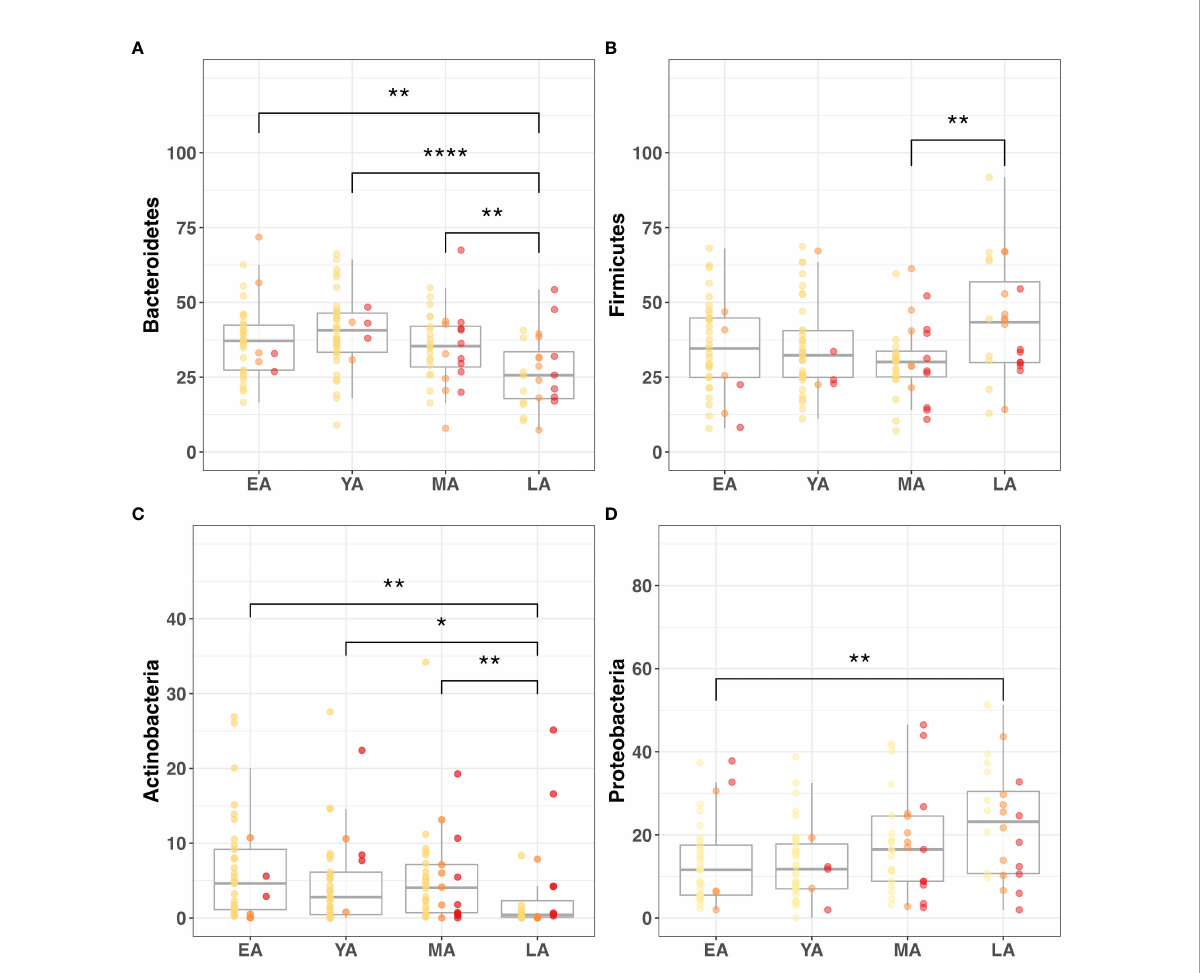
FIGURE 5 Gut microbiome composition dynamics upon age strati fi cation. Graphical representation of signi fi cantly different relative abundance of four major gut bacterial phyla across age groups. Color-coded indications of individual data points categorized by T2DM risk: non-diabetic (yellow), pre-diabetic (orange), and diabetic (red). Visualized phyla include (A) Bacteroidetes , (B) Firmicutes , (C) Actinobacteria , (D) Proteobacteria. Statistical signi fi cance denoted in fi gures above using asterisks as follows: * (P<0.05); ** (P<0.01); ****